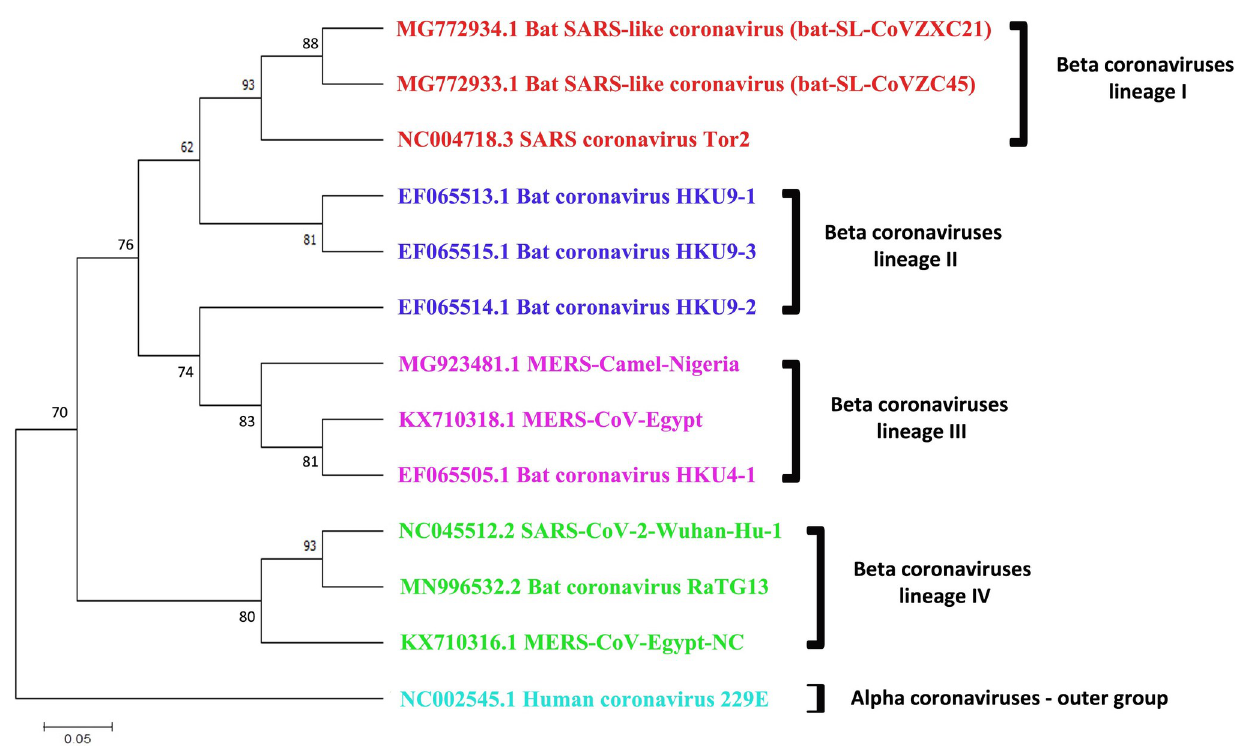
Fig 7. Phylogenetic analysis of SARS-CoV, MERS-CoV and SARS-CoV-2 (COVID-19) based on Neighbor-Joining method. SARS-CoV and MERS-CoV highly pathogenic beta coronaviruses along with SARS-like bat coronaviruses closely linked to SARS-CoV-2. Number at nodes indicates support for bootstrap (100 replicates), and the bar of scale indicates the average number of substitutions per location. The alpha coronavirus HCoV-229E sequence were considered as the out-group.